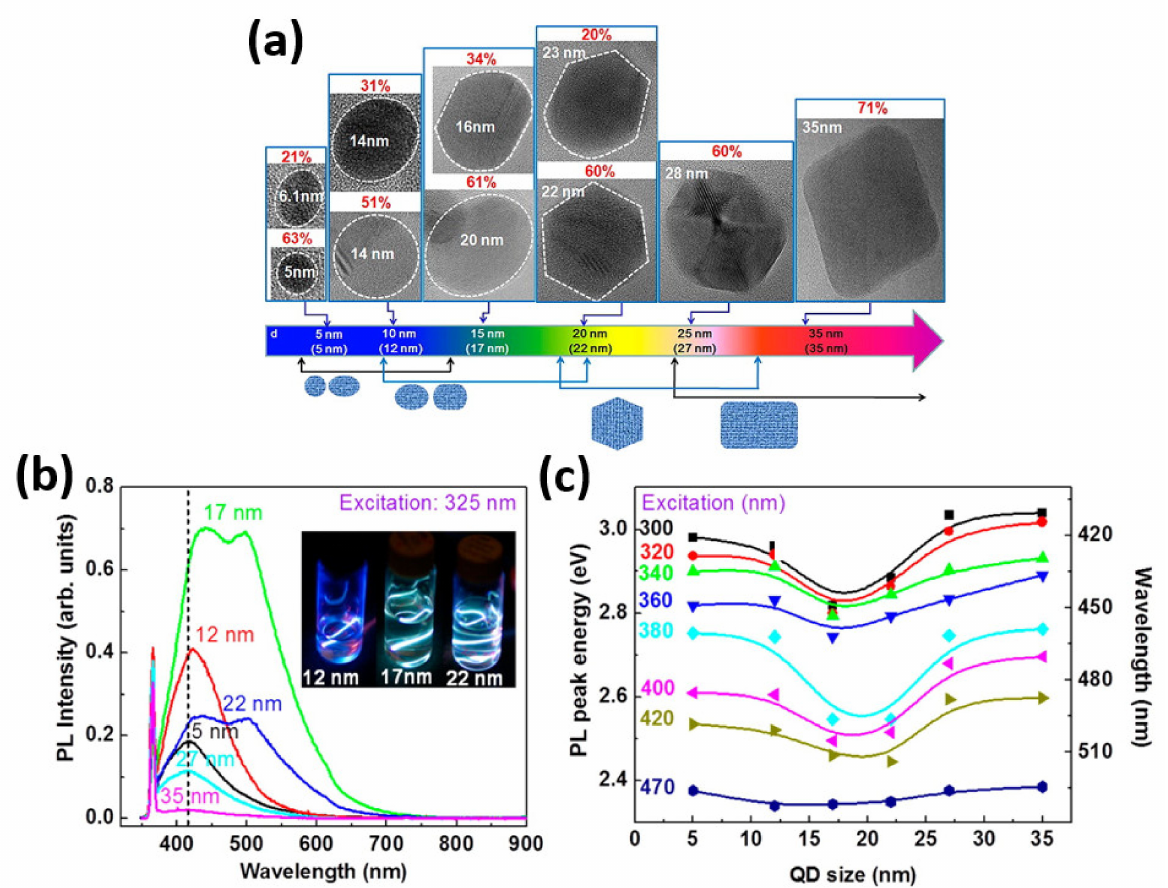
Figure 6. ( a ) HRTEM images of GQDs for their major shapes and corresponding populations (p) with increasing average size of GQDs. ( b ) Size-dependent PL spectra excited at 325 nm for GQDs of 5–35 nm average sizes in DI water. ( c ) Dependence of PL peak shifts on the excitation wavelength from 300 to 470 nm for GQDs of 5–35 nm average sizes. [76] Figure reproduced with permission from ACS